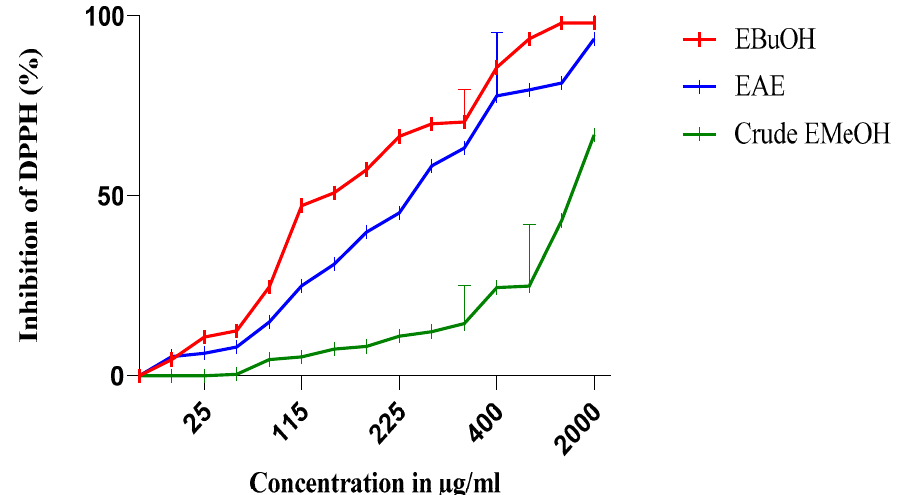
Figure 1. Inhibition of DPPH (%) by the n-butanol (EBuOH), ethyl acetate (EAE), and crude methanolic extract (crude EMeOH) fractions of N. sativa seeds.